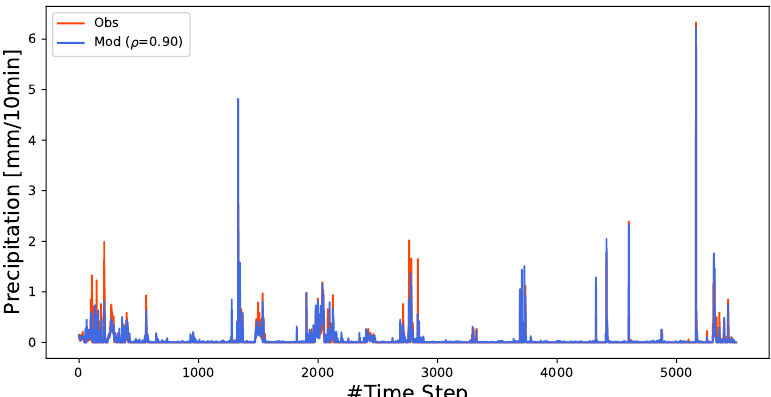
Figure A2. Observed (rain gauge data, Obs (red)) and modelled (Neural Network, Mod (blue)) precipitation in 10-min temporal resolution at location Hohenpeissenberg. Validation period (20% of the available data points).